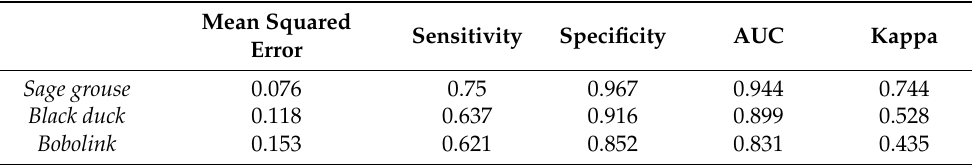
Table 2. Validation metrics for each of the focal species random forest models.